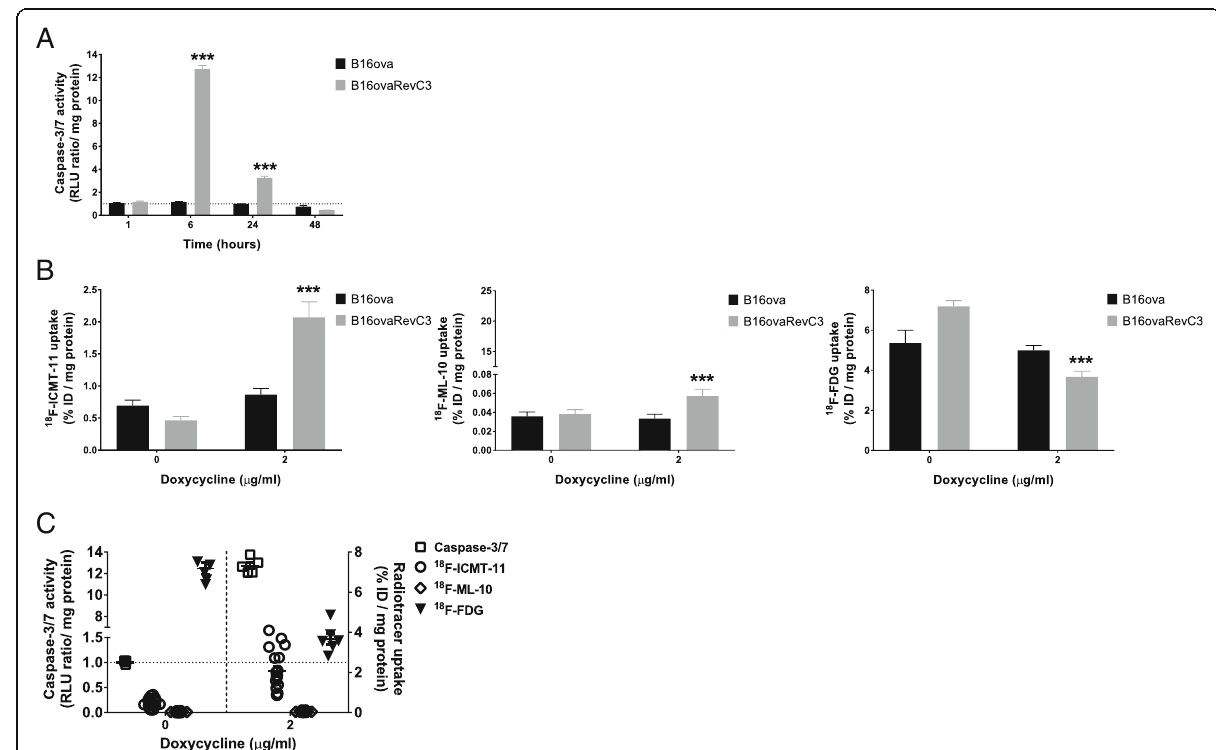
Fig. 2 In vitro caspase activity and uptake of radiotracers in response to death-switch induction. a Caspase-3/7 activity in B16ova and B16ovaRevC3 cells in response to various duration of exposure to doxycycline (2 μ g/ml). Significantly increased caspase activity was observed in B16ovaRevC3 cells at 6 and 24 h compared with respective controls (13- and 3-fold increase, respectively) and compared with B16ova cells treated with doxycycline ( p < 0.001, Student ’ s t test). b Radiotracer uptake was evaluated following treatment with doxycycline (2 μ g/ml) for 6 h. There were no significant differences in the uptake of any of the radiotracers in B16ova cells. Significantly increased uptake of 18 F-ICMT-11 ( p < 0.001) and 18 F-ML-10 ( p < 0.05), and significantly decreased uptake of 18 F-FDG ( p < 0.001) was observed in B16ovaRevC3 cells after death-switch induction (two-way ANOVA). Significantly higher uptake of 18 F-ICMT-11 ( p < 0.001) and 18 F-ML-10 ( p < 0.01) and significantly lower uptake of 18 F- FDG ( p < 0.05) were observed in B16ovaRevC3 cells compared with B16ova cells treated with doxycycline (multiple t tests). c Caspase-3/7 activity correlated with increased 18 F-ICMT-11 and decreased 18 F-FDG uptake in B16ovaRevC3 cells after death-switch induction. Assays were conducted in triplicate using six replicates per experiment. Data are presented as mean ± SEM. * indicates significant difference between B16ova and B16ovaRevC3 treated with doxycycline; ** indicates significant difference between doxycycline-treated B16ovaRevC3 and untreated B16ovaRevC3; *** indicates significant difference between doxycycline-treated B16ovaRevC3 and untreated B16ovaRevC3, and doxycycline-treated